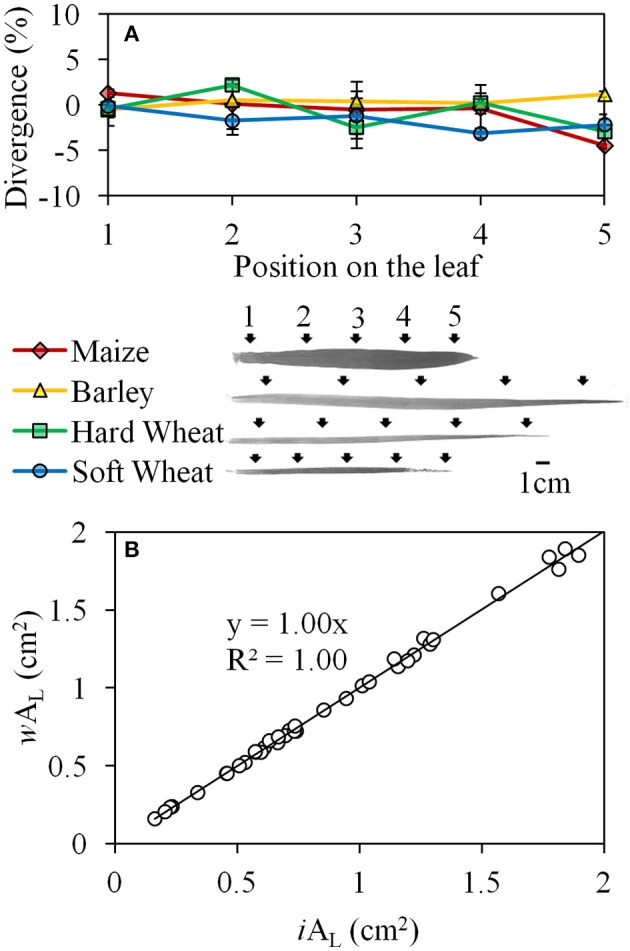
The divergence (%) of wAL from iAL when AL was quantified on five different positions (black arrows) along the leaves of maize, barley, hard and soft wheat (A); the linear relation between iAL and wAL when the data points from all the species and the positions on the leaf were incorporated (B). Error bars indicate the standard error.